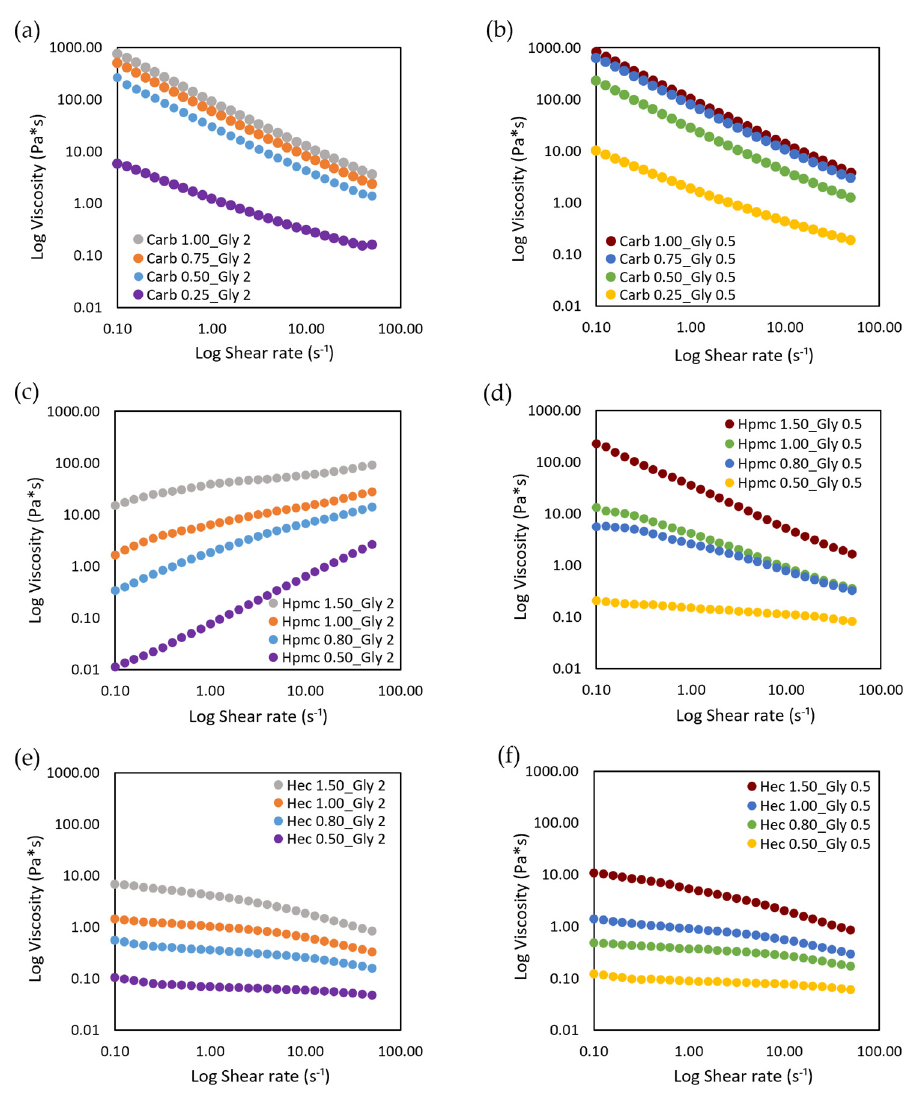
Figure 1. Viscosity vs. shear-rate curves of alcohol-based gel sanitizers. The curve is the average of three measures. ( a , b ) Carbopol-based gels; ( c , d ) HPMC-based gels; ( e , f ) HEC-based gels.